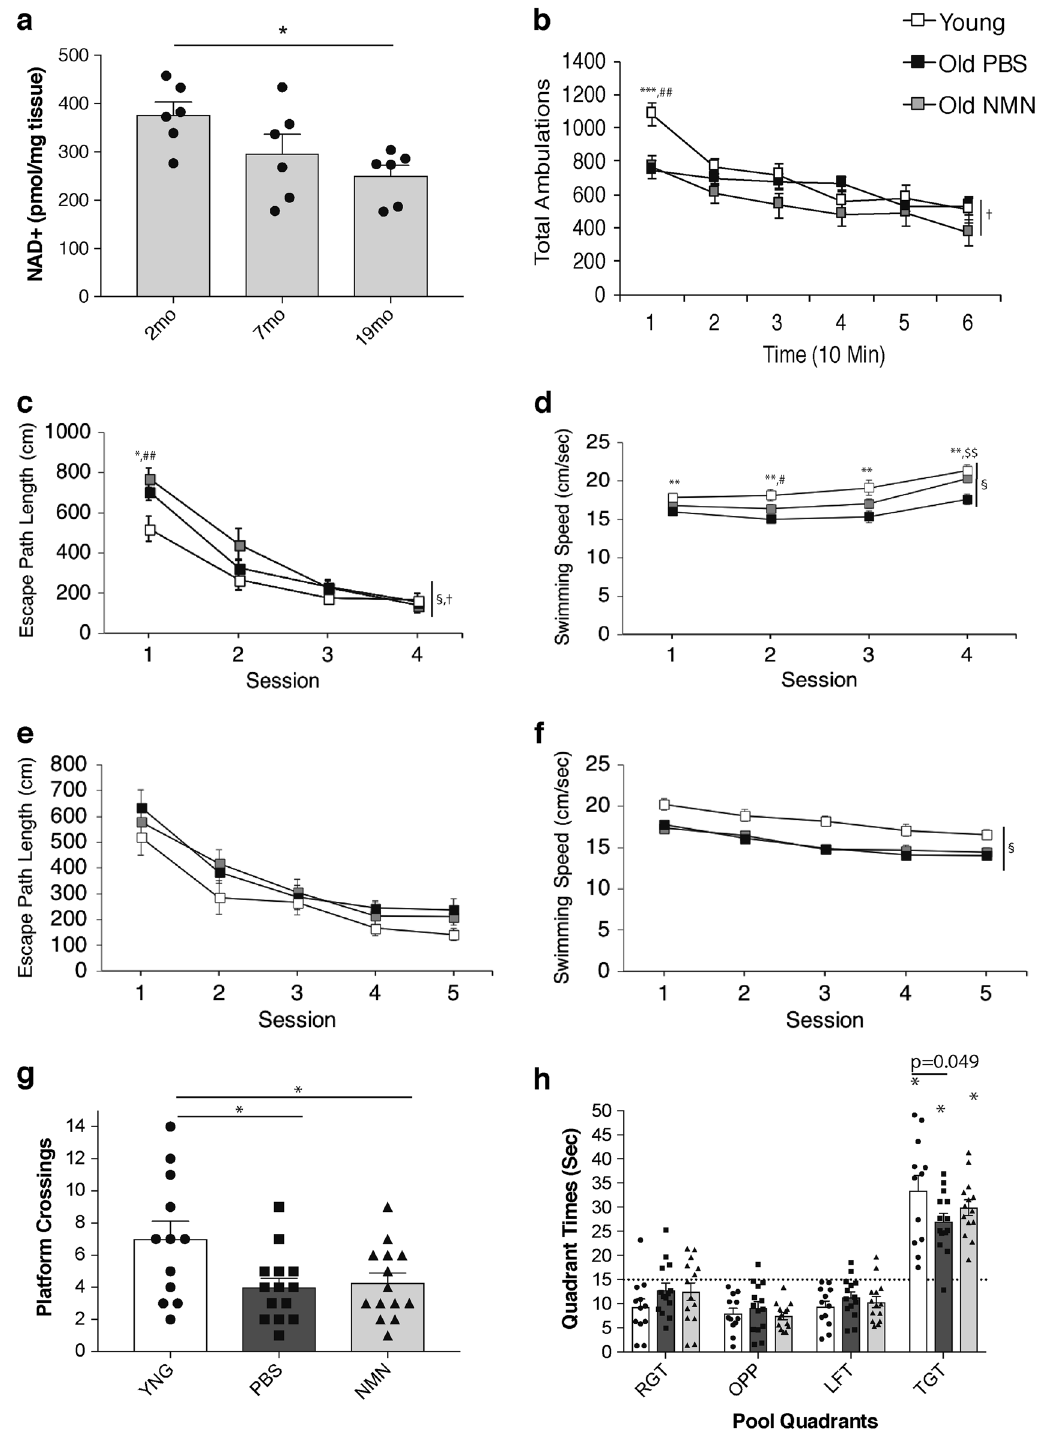
Fig. 1 Old mice show signi fi cant decreases in hippocampal NAD + levels but retain their spatial acquisition and learning capabilities. a Hippocampal NAD + levels in male mice at 2, 7, and 19 months of age ( n = 6; * p < 0.05, one-way ANOVA with LSD post hoc test). b Total ambulations were measured in the 1 h locomotor activity tests on PBS-treated 2-month-old ( n = 12), PBS-treated 20-month-old ( n = 14), and NMN-treated 20-month-old ( n = 14) male mice. c – h Evaluation of PBS-treated 2-month-old ( n = 12), PBS-treated 20-month-old ( n = 14), and NMN-treated 20-month-old ( n = 14) male mice in the MWM tests. Escape path lengths and swimming speeds during the cued ( c , d ) and place ( e , f ) conditions are shown. Platform crossings ( g ) and times spent in each quadrant ( h ) during the probe condition are also shown. Data are presented as mean ± SE. Statistical analyses were conducted by two-way repeated measures ANOVA for ( b – f ) and one-way ANOVA for ( a , g , h ). Signi fi cant group effects and group by time or sessions interactions are denoted by symbols at the right sides of the graphs (§ and † , respectively). b – f * p < 0.05, **, ##, $$ p < 0.01, ***, ### p < 0.001 (*, **, *** for PBS-treated young vs. PBS-treated old mice; #, ## for PBS-treated young vs. NMN-treated old mice; $$ for PBS-treated old vs. NMN-treated old mice). g * p < 0.05 for the comparison to PBS-treated young mice. h Signi fi cant spatial bias toward the target quadrant is denoted